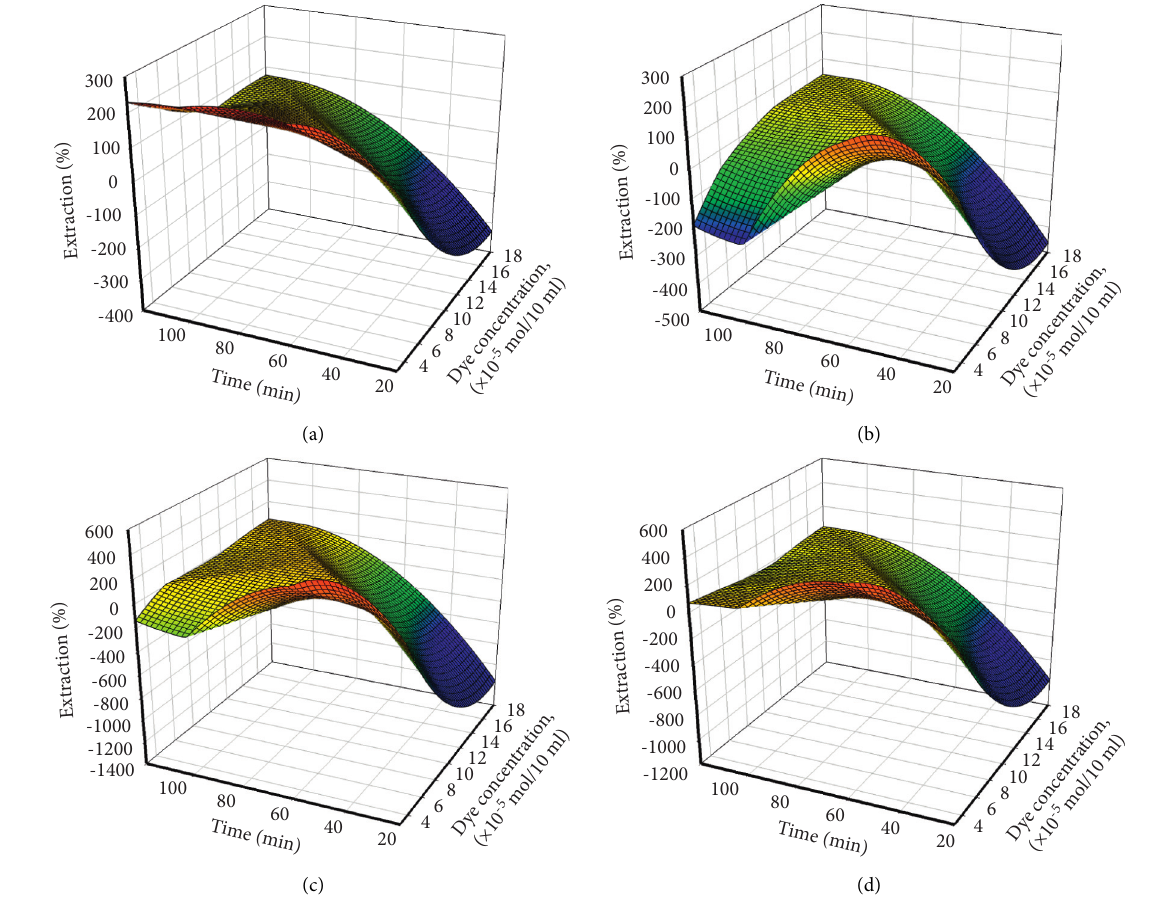
Figure 9: 3D plots of the interaction influence of the time contact with the initial concentration of dye on extraction% of RY145 by (a) CTAB and (b) SDS and RB222 by (c) CTAB and (d)